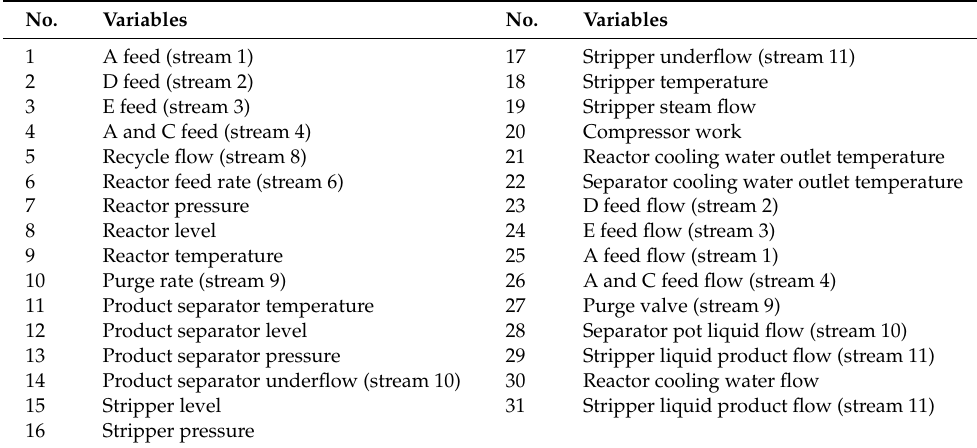
Table A1. The process variables of TE benchmark